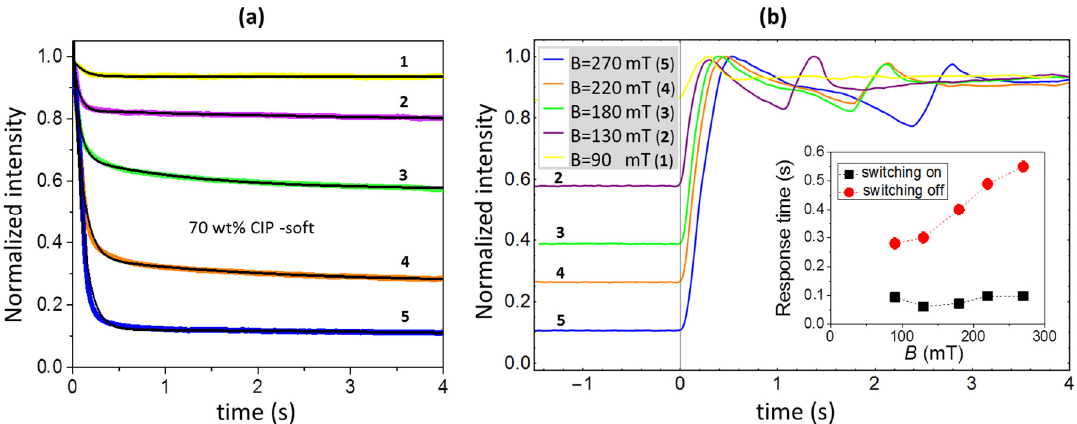
Figure 8. The time dependencies of the normalized reflected intensity detected after switching the magnetic field of various magnitude either ( a ) on or ( b ) off: Yellow (1) B = 90 mT, purple (2) B = 130 mT, green (3) B = 180 mT, orange (4) B = 220 mT and blue (5) B = 270 mT. The black lines in Figure 8a show exponential fits. The inset in Figure 8b shows the obtained response times as a function of the magnetic field. All data are given for the soft MAE with a 70 wt% of CIP.